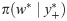
Acceptance rates for the original SVE algorithm and SVE using π(w*∣y+*) as proposal.The average acceptance rate for sampling from posterior distributions π(θ ∣ x+) when using the original SVE algorithm (left panel) and when using the proposal distribution π(w*∣y+*=x+) (right panel).